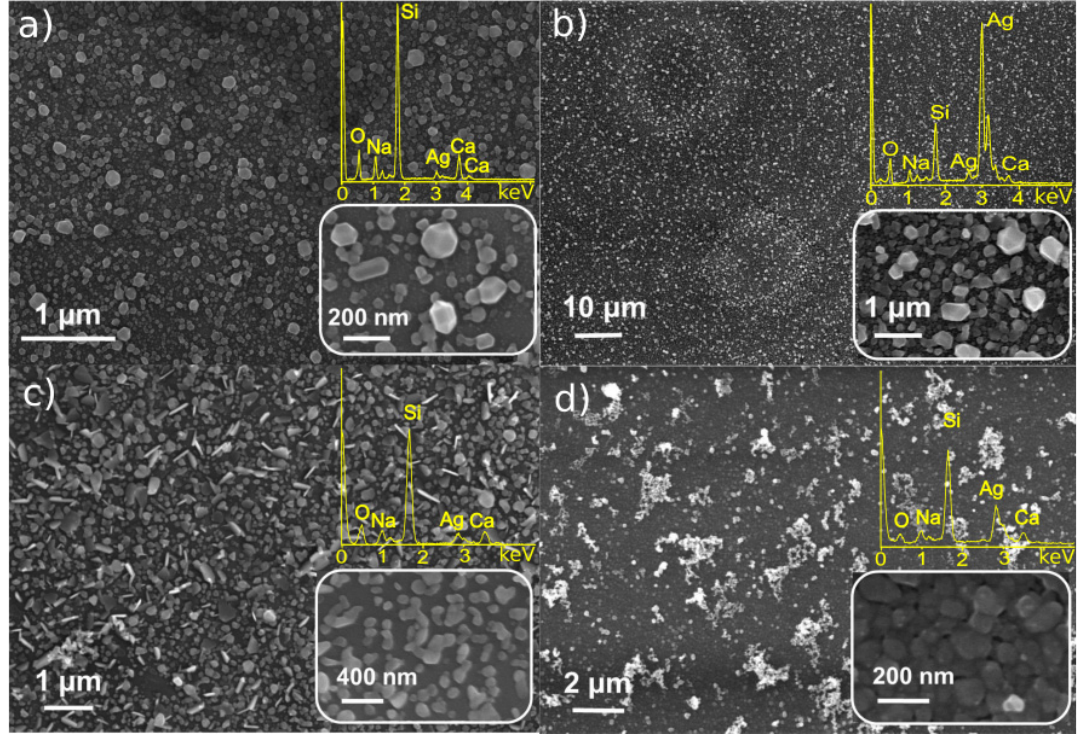
Figure 2. SEM/EDX analysis of Ag particles on cover glass synthesized from ( a ) C 6 H 5 COOAg in methanol (0.4 mM), ( b ) C 6 H 5 COOAg in acetonitrile (1.3 mM), ( c ) (CF 3 SO 2 ) 2 NAg in ethanol (3.3 mM), ( d ) (CF 3 SO 2 ) 2 NAg in isopropanol (2.8 mM).